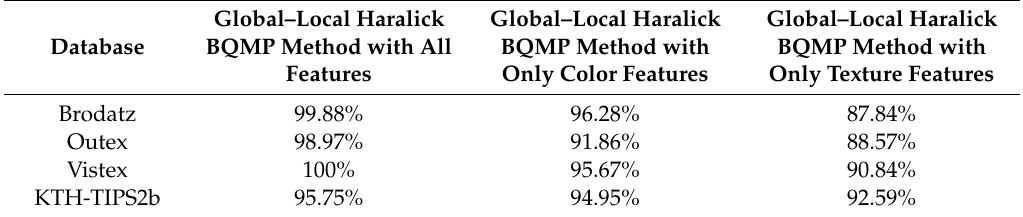
Table 9. Best results of global–local Haralick–BQMP classification for the all databases with the contribution of each part of the model (color and spatial